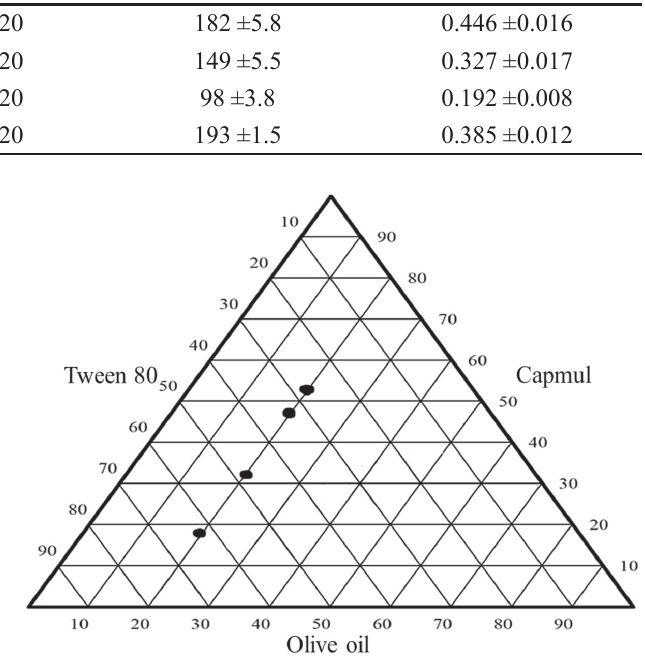
TABLE I - The selected formulations that have droplet sizes below 200 nm Formulation